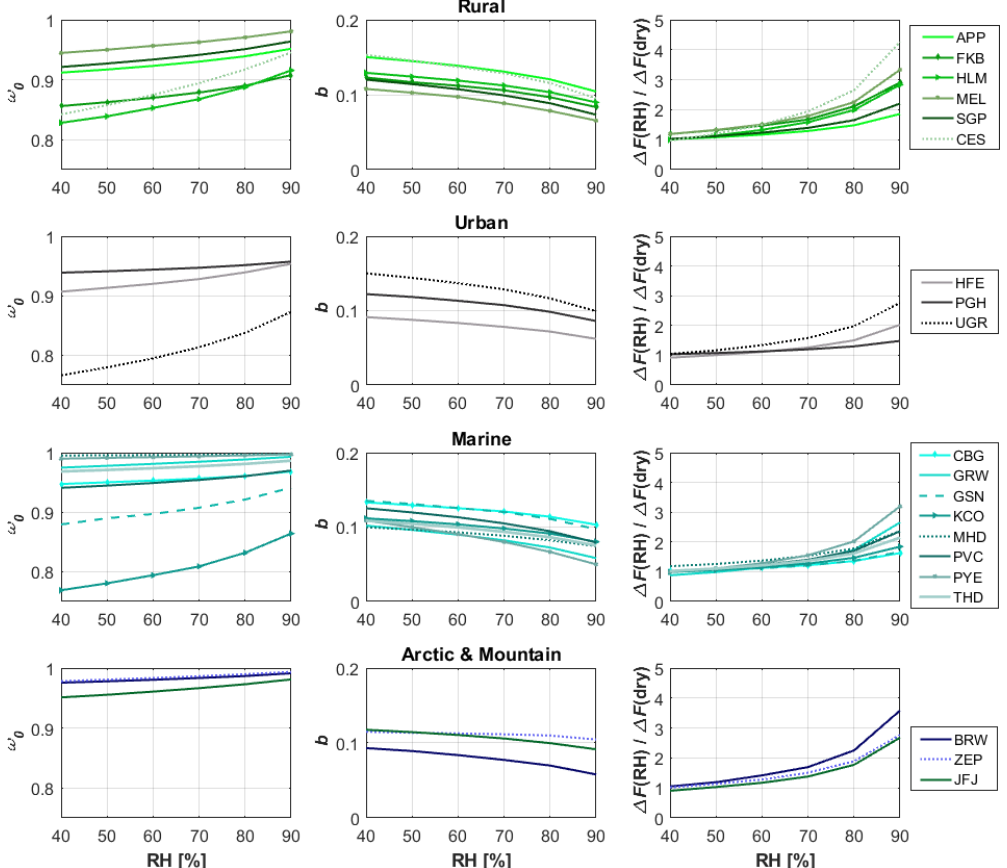
Figure 5. Median values of single-scattering albedo, backscatter fraction and ratio of the radiative forcing at certain RH to the radiative forcing at dry conditions (RH < 40%). All variables refer to the 550nm